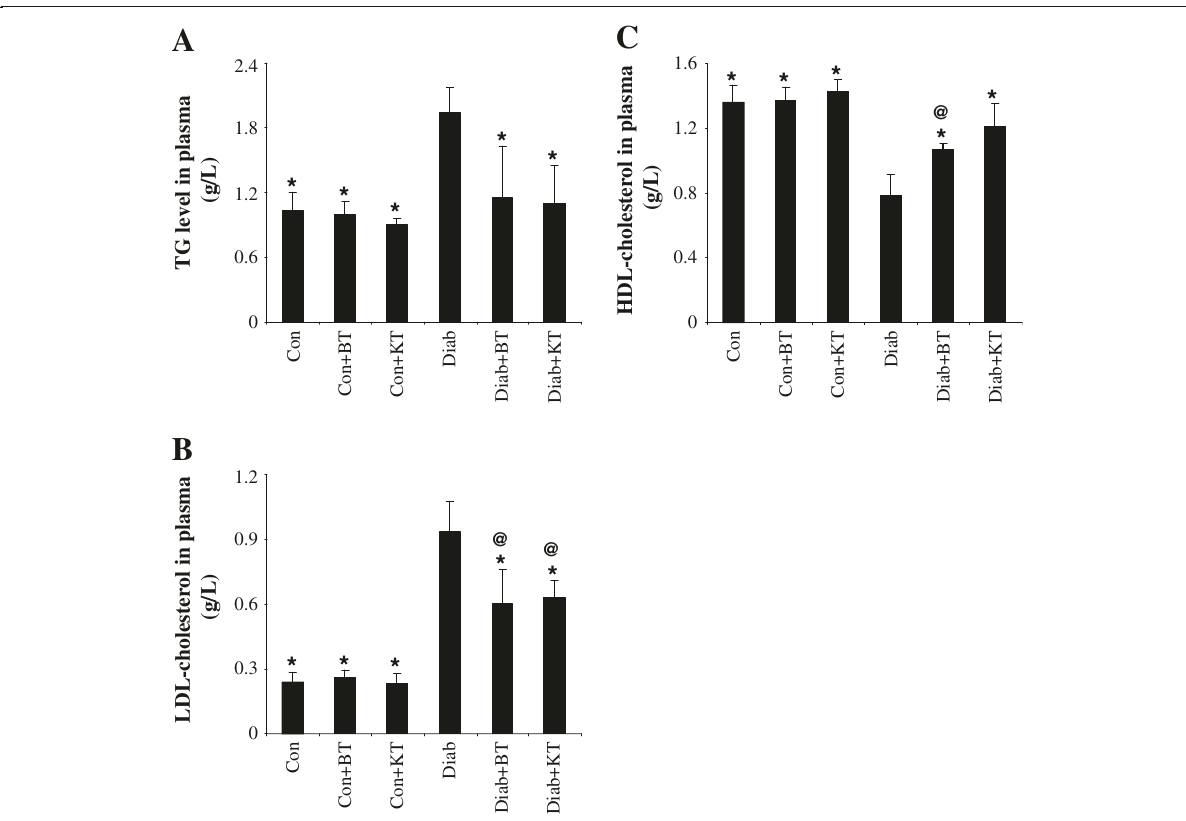
Figure 4 Effect of KT and BT on TG (A), LDL-Ch (B), and HDL-Ch (C) levels in plasma of surviving diabetic rats. Data represent mean±S.D (n=8 for each group). The values are statistically significant and presented as follows: single asterisk (*), p < 0.05 vs. control diabetic rats (Diab); commercial at (@), p < 0.05 vs. respective control rats (Con) [i.e. on the same corresponding tea treatment]; number sign (#), p < 0.05 vs. diabetic rats treated with BT